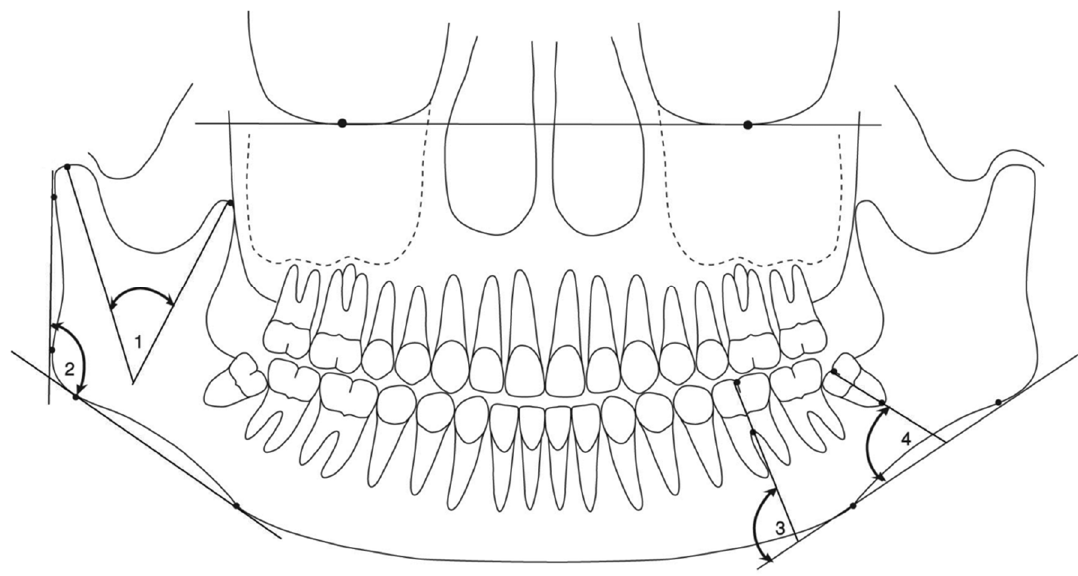
Figure 1. Linear measurements.